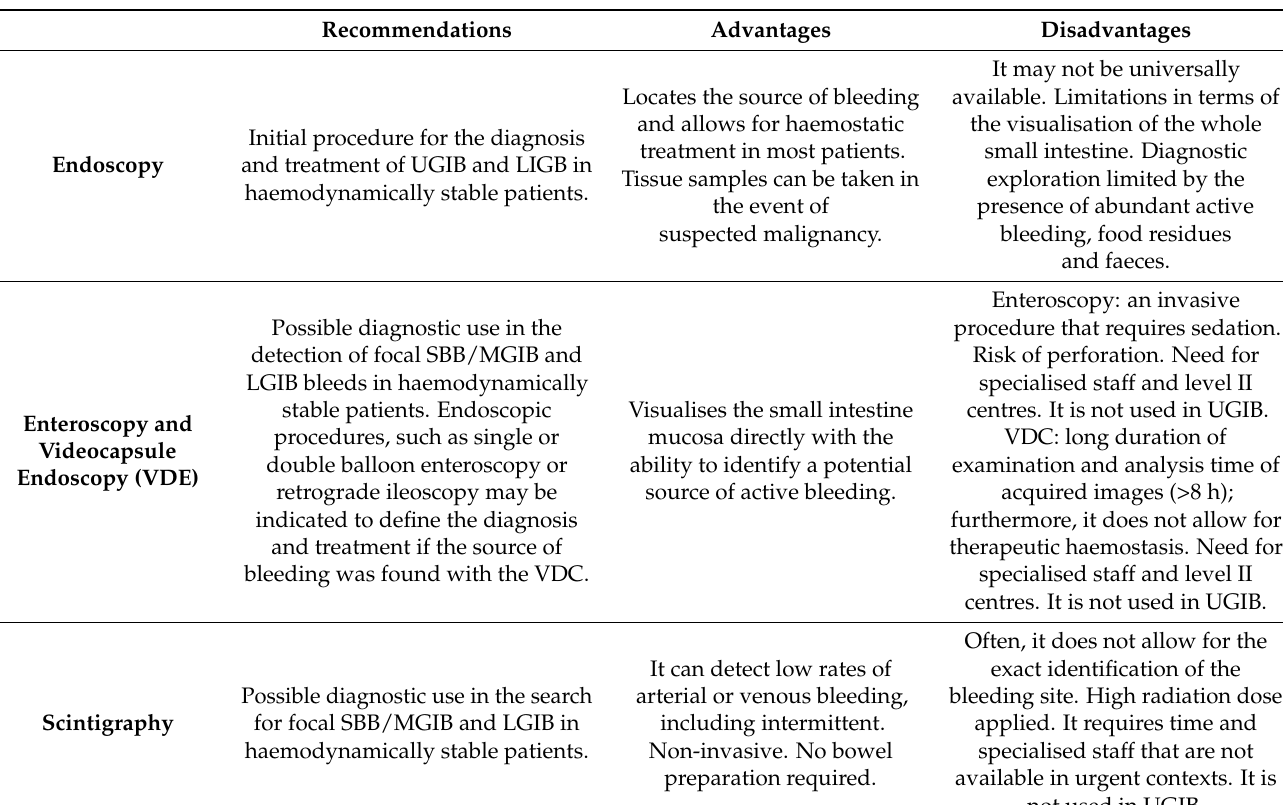
Table 2. Recommendations, advantages and limitations of the use of the various endoscopic and imaging